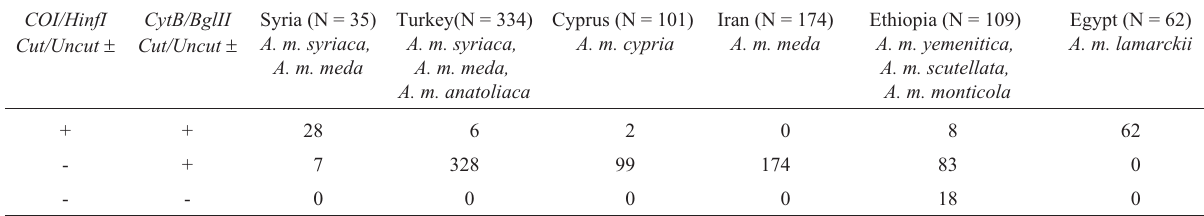
Table 1 - Restriction analysis of PCR amplified CO I and Cyt B regions of mtDNA of honey bee samples collected from different countries. COI/HinfI Cut/Uncut